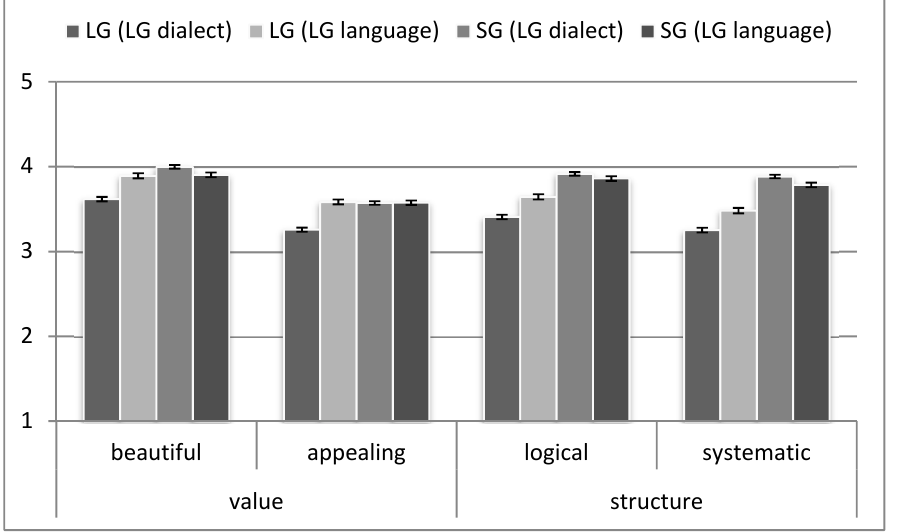
Figure 8. Evaluations of Low German (LG) and Standard German (SG) by Low German’s status assessment (AToL scale, NGS2016).